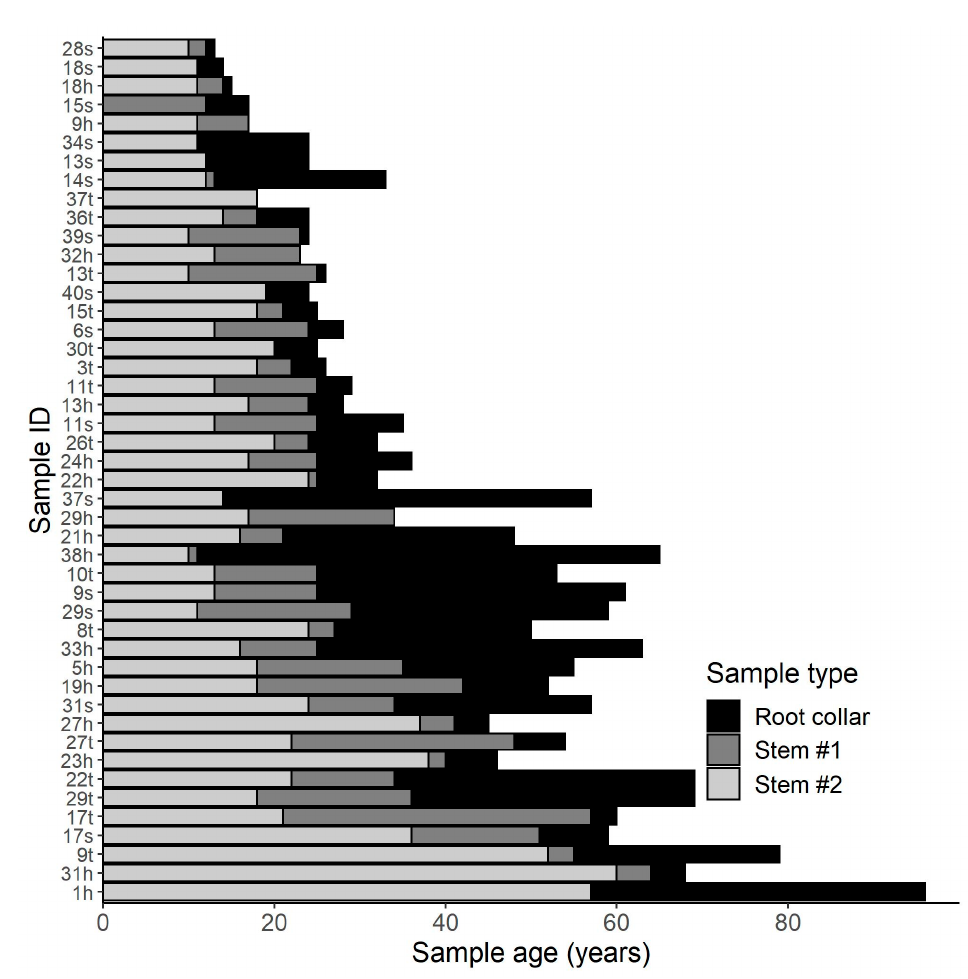
Figure 2. The age of the root collar (black) and stems (grey) of each sampled shrub (horizontal lines). Letters at the end of the shrub IDs represent the site from which they originated (t = terrace, h = hilltop, s = snowbed).